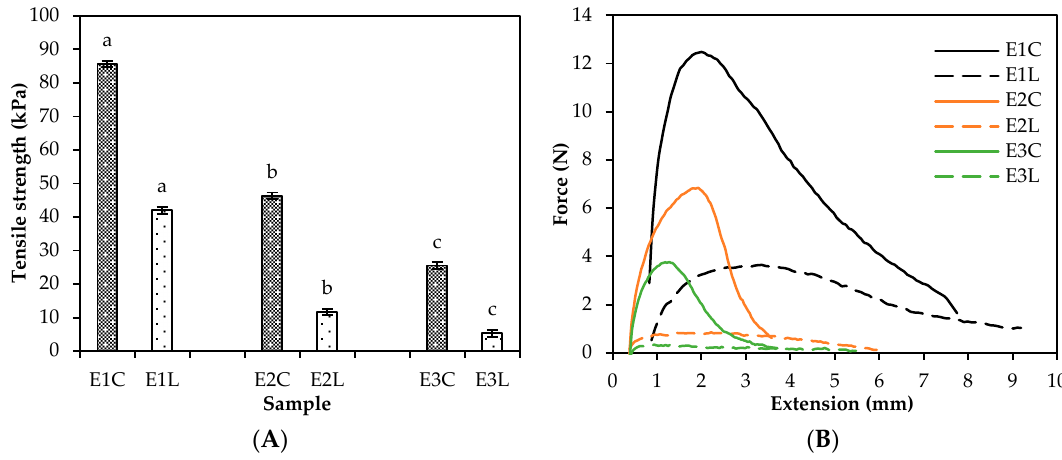
Figure 2. Longitudinal (L) and cross ‐ directional (C) ( A ) tensile strength (kPa) of the extrudates (E1–E3), ( B ) tearing force (N) of the extrudates (E1–E3) as a function of extension (mm). Different letters (a, b, c) indicate the significant differences ( p < 0.05) within sample groups ER1–ER3 and E1–E3.